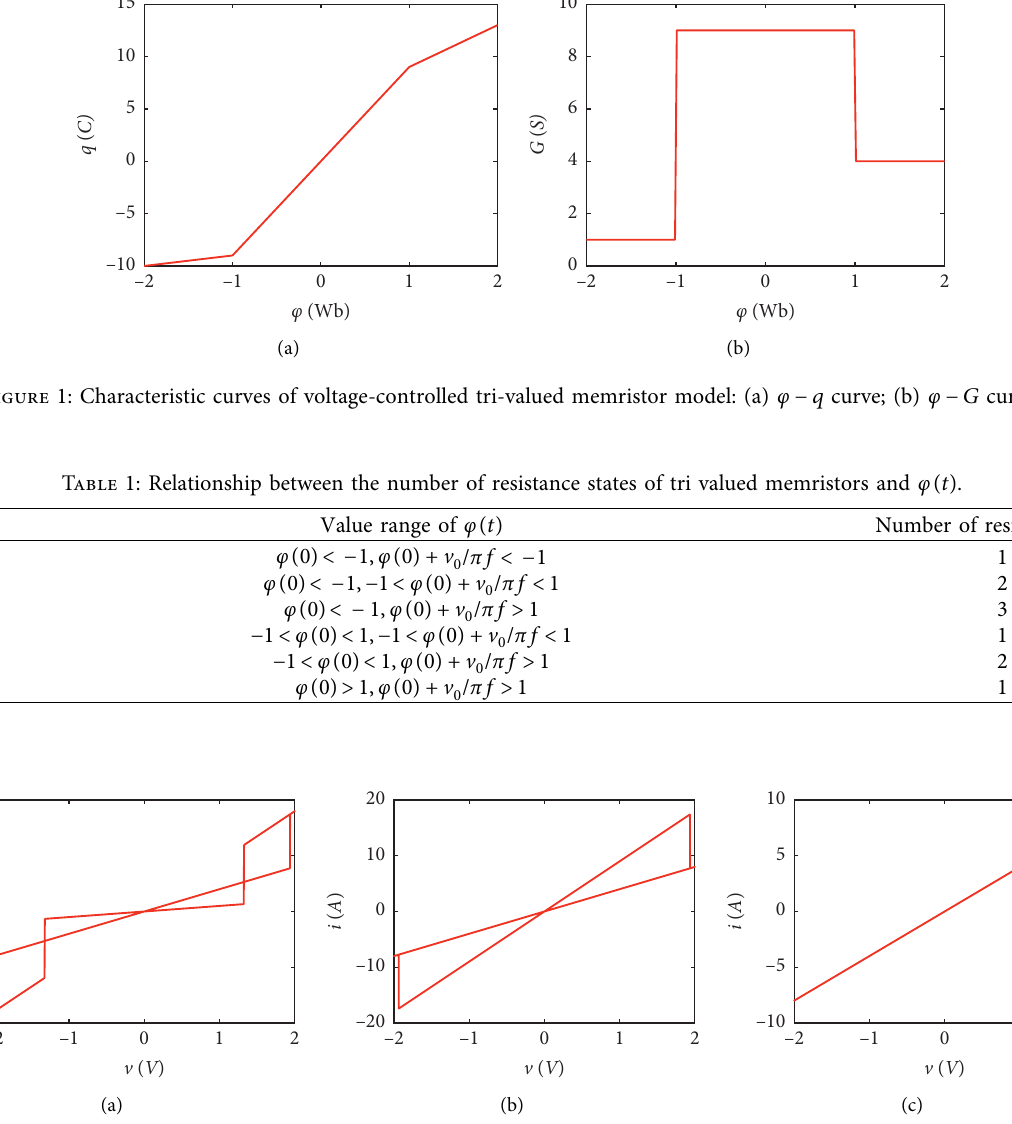
Figure 2: v-i curve of tri-valued memristor at different initial values: (a) φ ( 0 ) � − 1 . 5 (Case3), (b) φ ( 0 ) � − 0 . 5 (Case5), and (c) φ ( 0 ) � 1 . 5